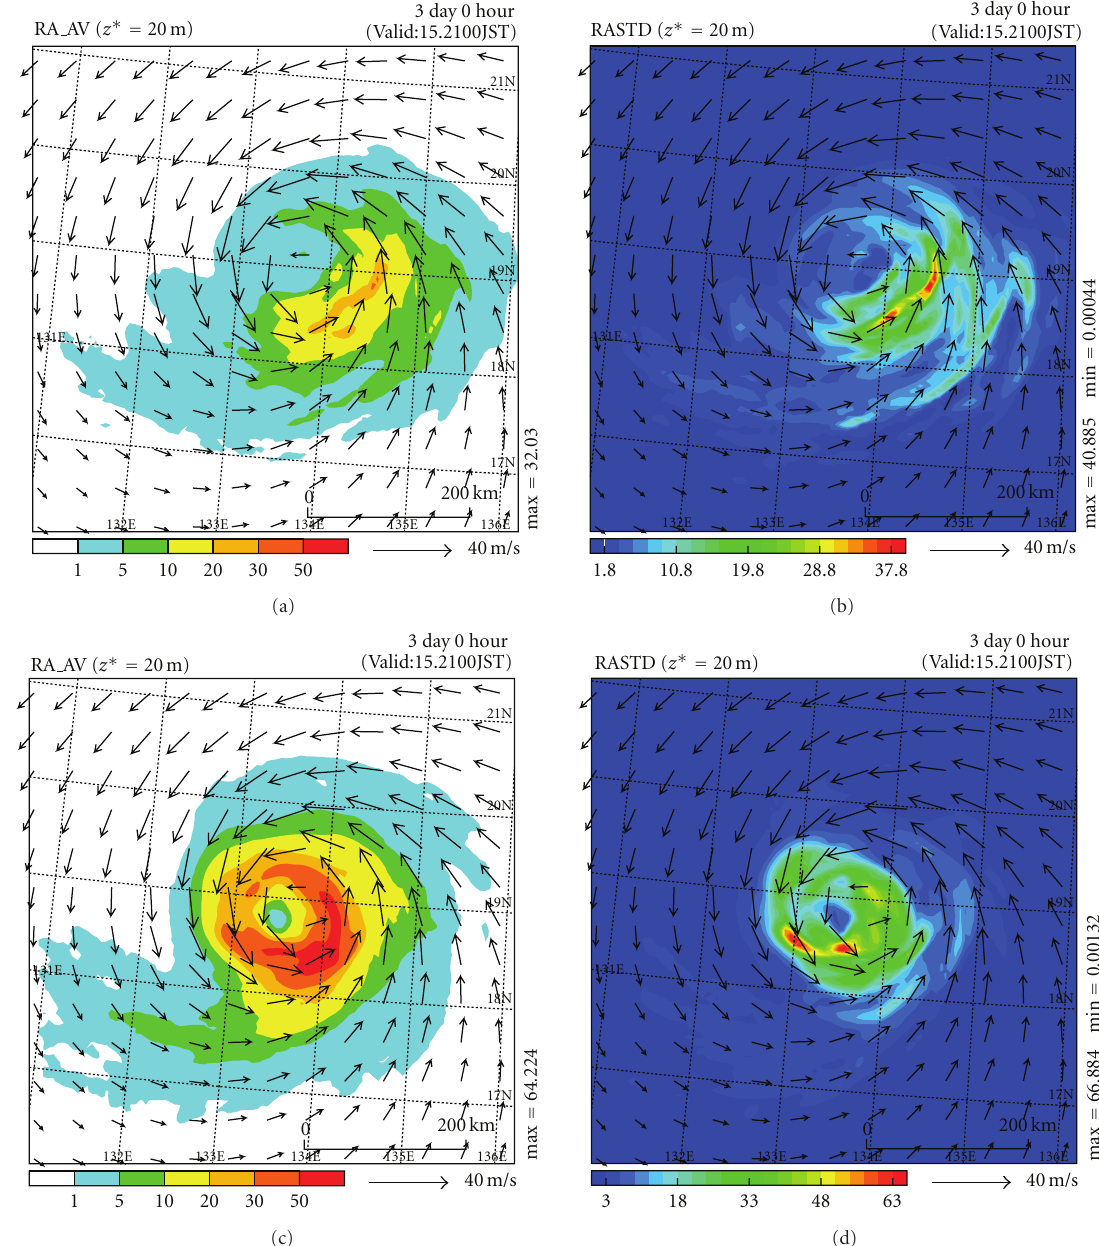
Figure 13: Horizontal distribution of mean hourly precipitation (mm per hour) at 72h averaged over the nine NCM predictions and (b) that of the standard deviation at 72h; (c) and (d) are the same as (a) and (b), respectively, except that they show the NHM results. Mean horizontal wind field vectors at 72 h averaged over the nine NCM (in parts (a) and (b)) and NHM (in parts (c) and (d)) predictions are also shown in each